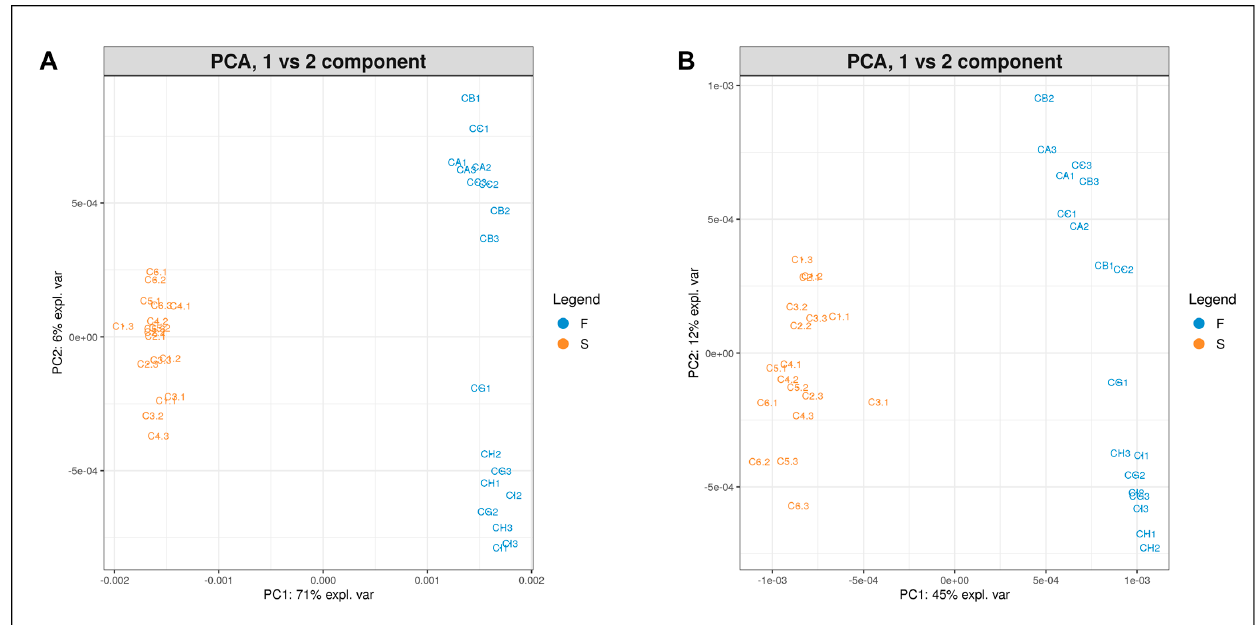
Figure 5. PCA plot (PC1 vs. PC2) of albumin ( A ) and globulin ( B ) extracts from certified seeds of Finola (F, blue) and Secuieni J. (S, orange) hemp varieties.